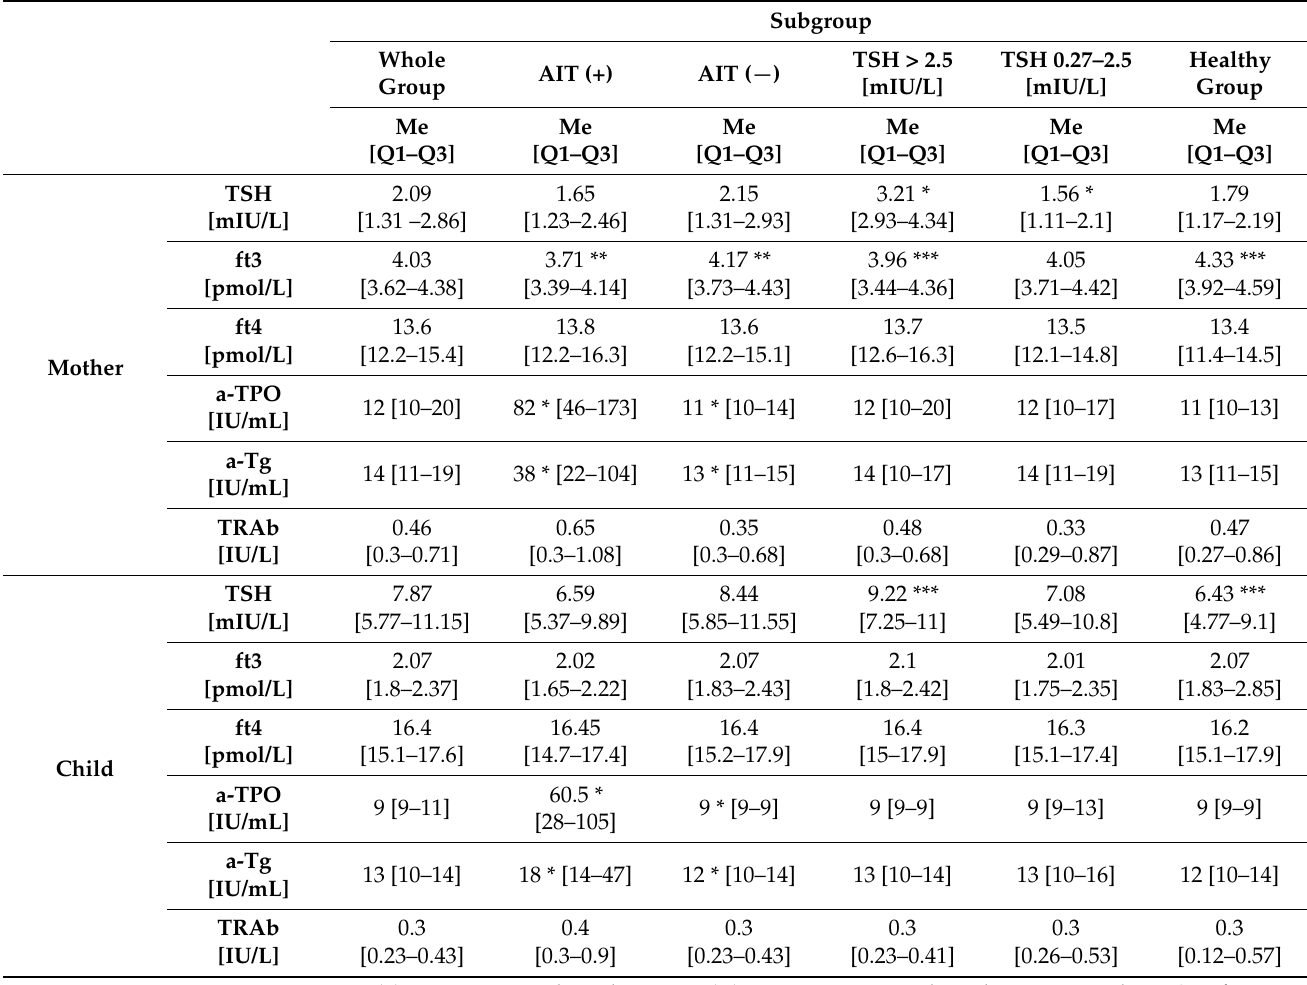
Table 1. Overview of thyroid hormone profiles in different thyroid states in mothers and children.